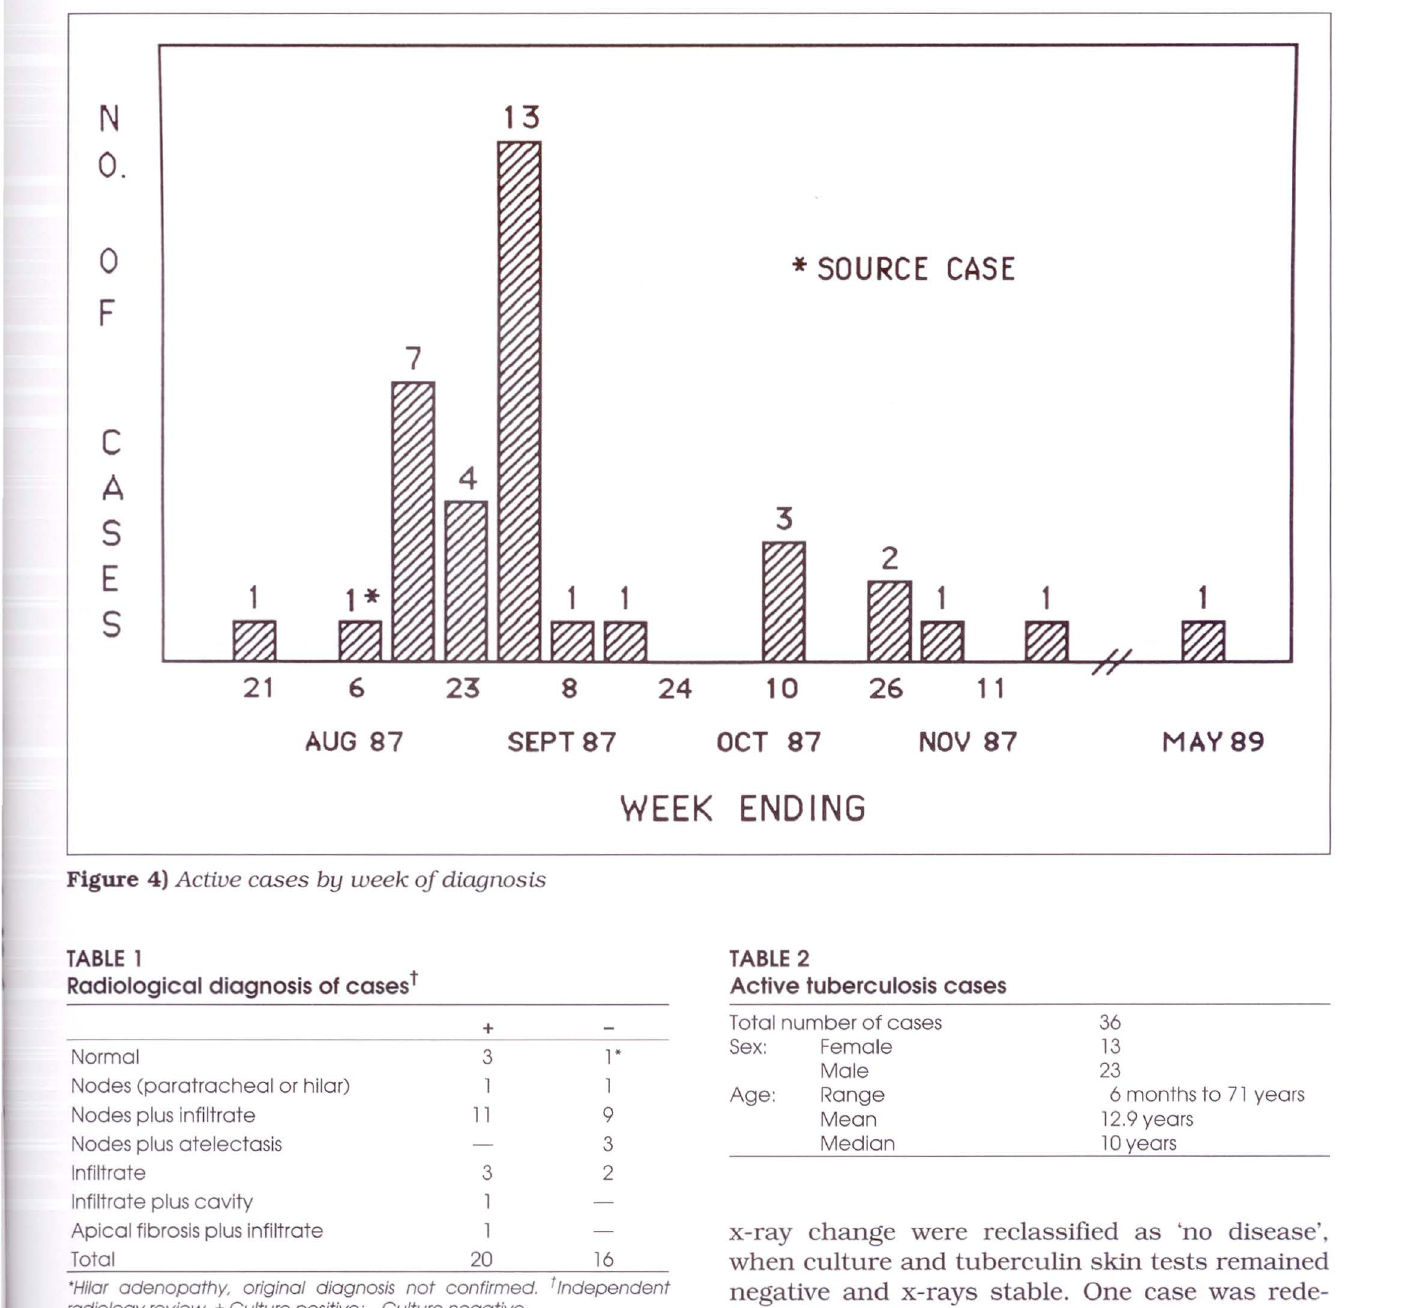
Radiological diagnosis of cases t Normal Nodes (paratracheal or hilar) Nodes plus infiltrate Nodes plus atelectasis Infiltrate Infiltrate plus cavity Apical fibrosis plus infiltrate Total